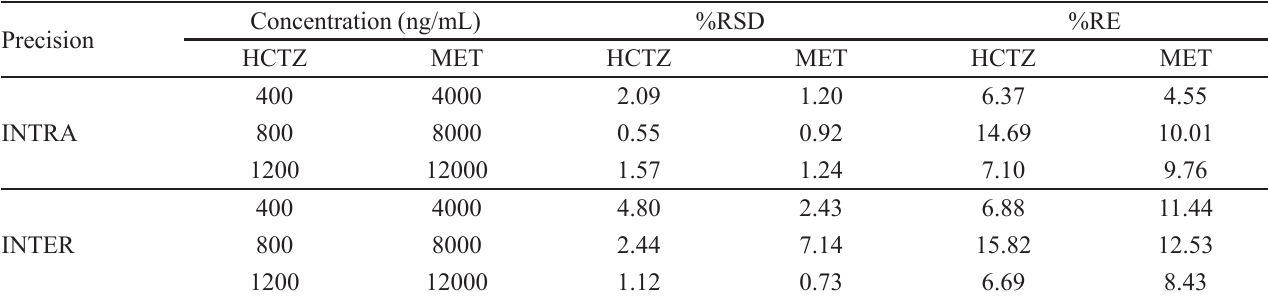
TABLE II - Results of precision of hydrochlorothiazide and metoprolol tartarate in human plasma